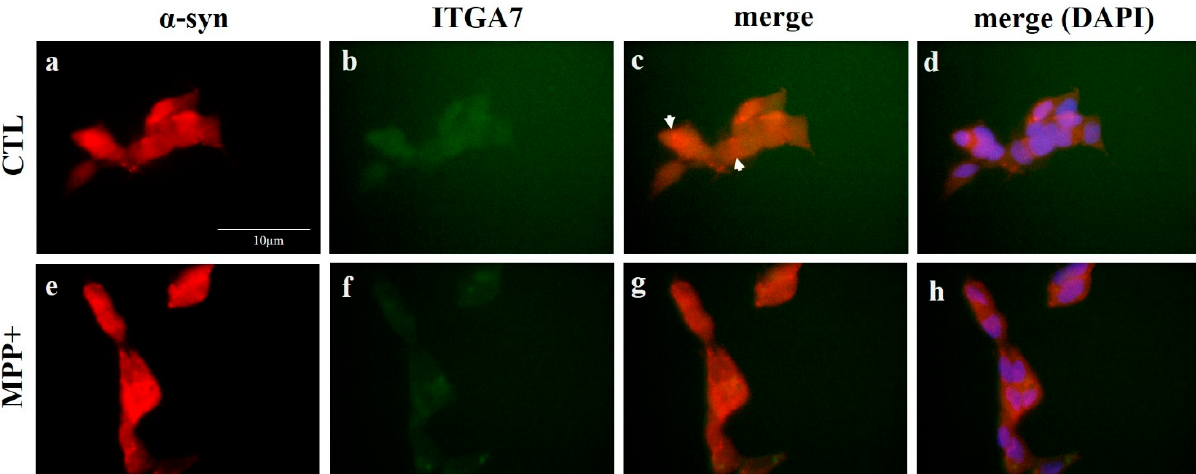
Figure 7. Immunofluorescence analysis of ITGA7 co-localized with α -syn in SH-SY5Y cell. The cells were immunofluores- cently labeled with anti-ITGA7 ( b , f ) and anti- α -synuclein ( a , e ) antibodies using Rhodamine Avidin ( a , e , red) and were then double immunolabeled with ITGA7 antibodies using Fluorescein Avidin ( b , f , green). The panels on the right ( c , g ) show merged images of the individual left ( a , e ) and middle ( b , f ) panels. ( d , h ) show merged images with DAPI (scale bar, 10 µm). White arrows indicate regions of interest.